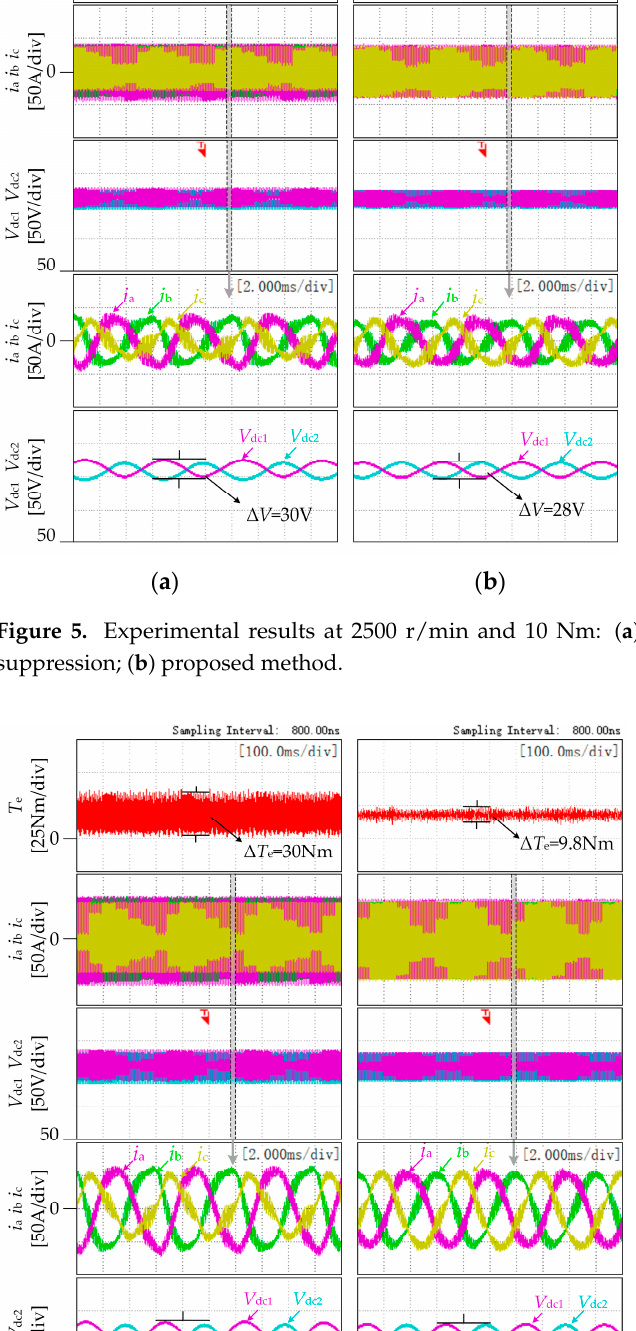
( b ) Figure 7. Experimental results at 2500 r/min and 30 Nm: ( a ) without capacitor voltage offset sup- pression; ( b ) proposed method.